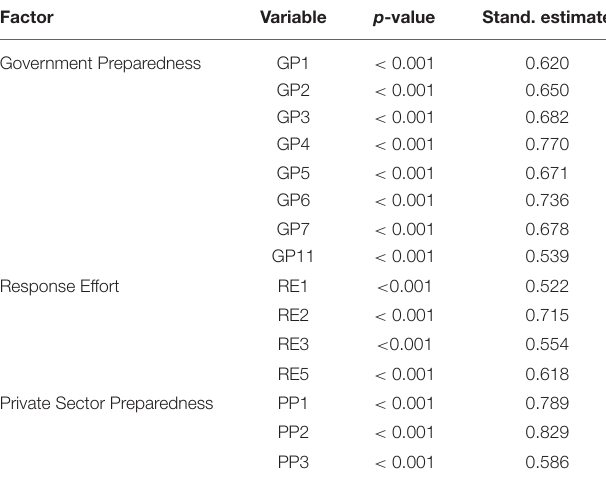
TABLE 5 | Revised factor loading and P -value of each variable. Factor Variable p -value Stand. estimate